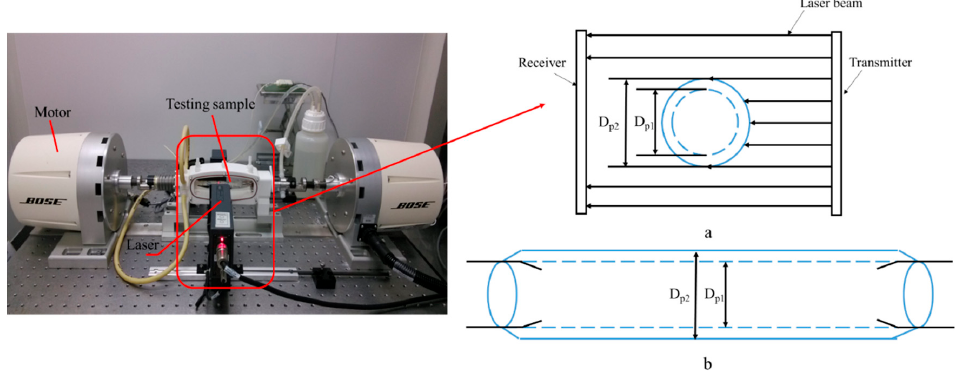
Figure 3. BOSE dynamic simulated system. Schematic of compliance test: ( a ) Cross section; and ( b ) main view, where D p 1 (mm) is the diameter under lower pressure and D p 2 (mm) is the diameter under higher pressure.